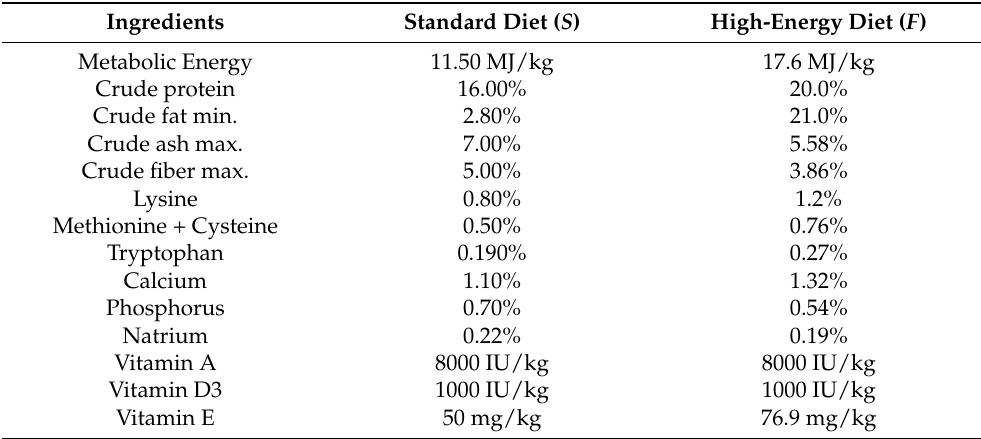
Table 1. Standard ( S ) and high-energy diets ( F )